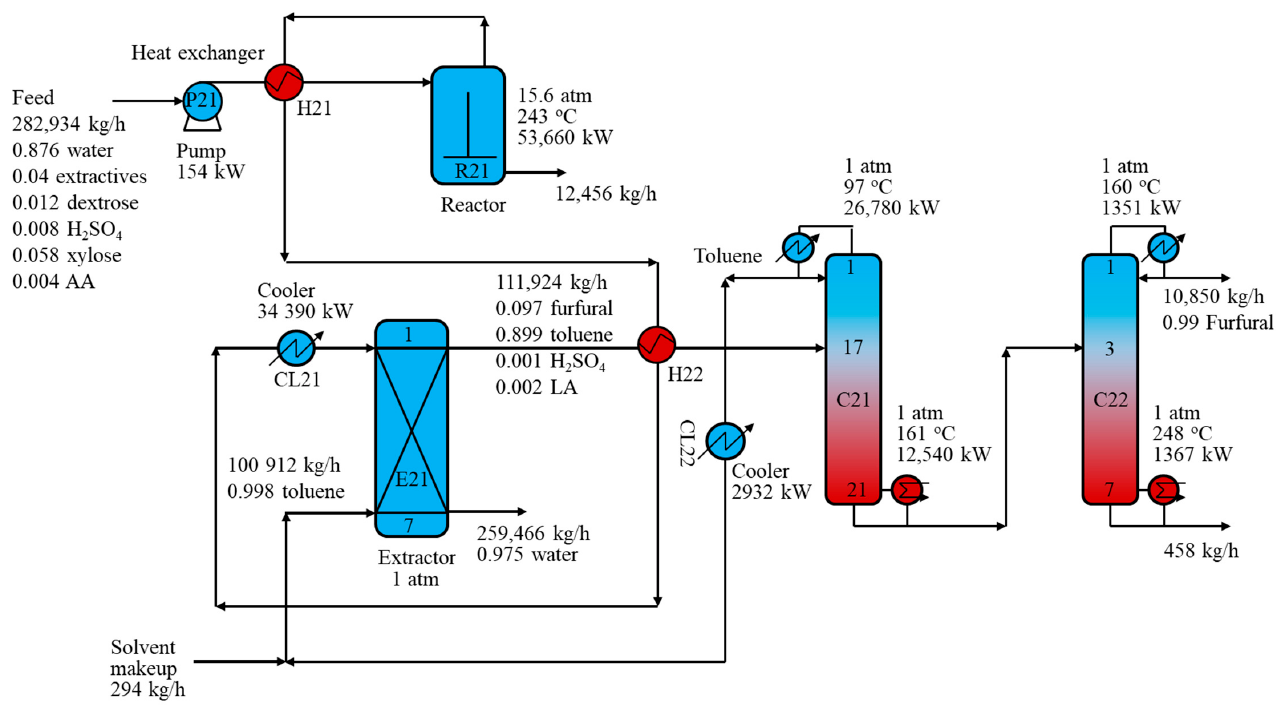
Figure 4. Schematic of the furfural reaction-extraction/distillation process with toluene solvent.